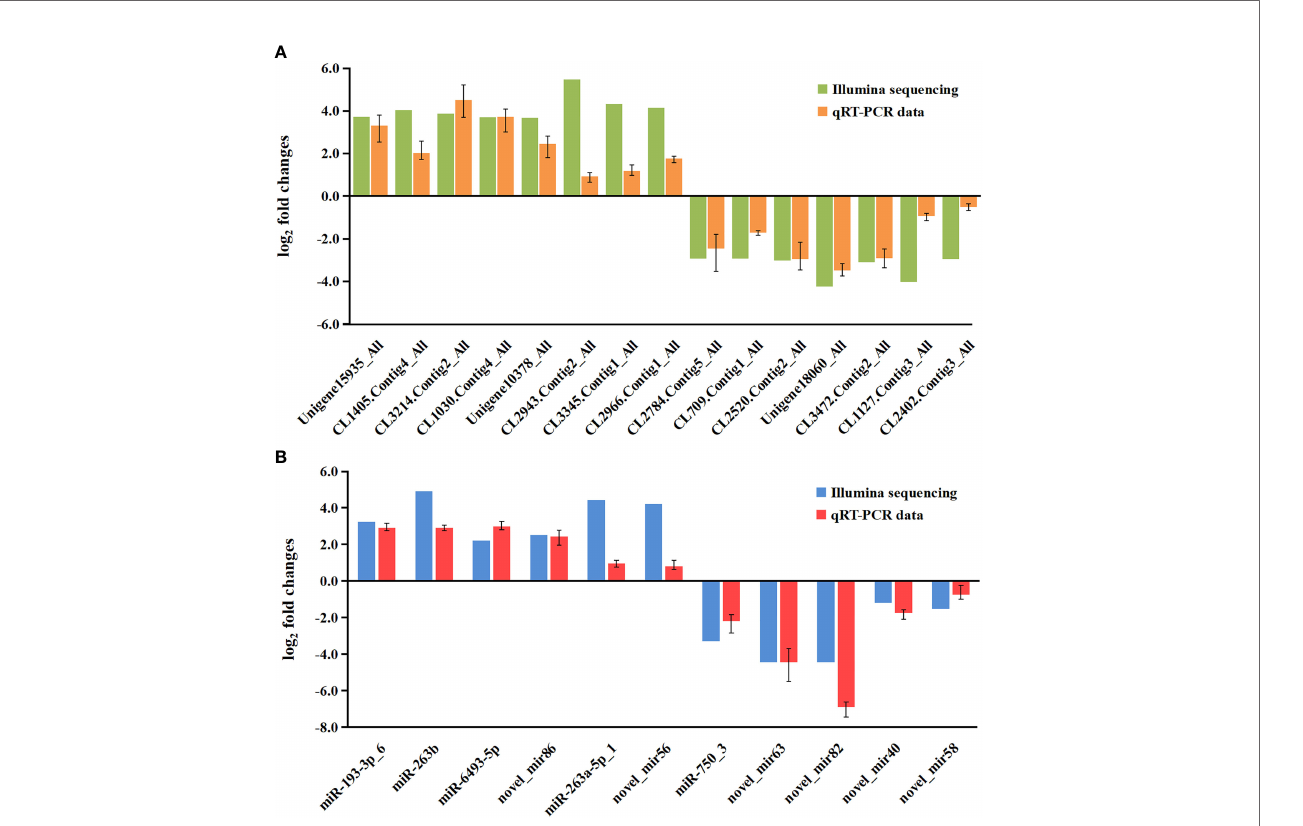
FIGURE 7 | Validation of RNA-seq results via qRT-PCR. (A) Comparison of the expression pro fi les of 10 DEGs as determined by Illumina sequencing and qRT- PCR. The x-axis indicates the names of the DEGs, and the y-axis represents the log 2 (fold change). (B) Comparison of the expression pro fi les of 8 DEMs as determined by Illumina sequencing and qRT-PCR. The x-axis indicates the names of the DEMs, and the y-axis represents the log 2 (fold change). DEGs, differentially expressed